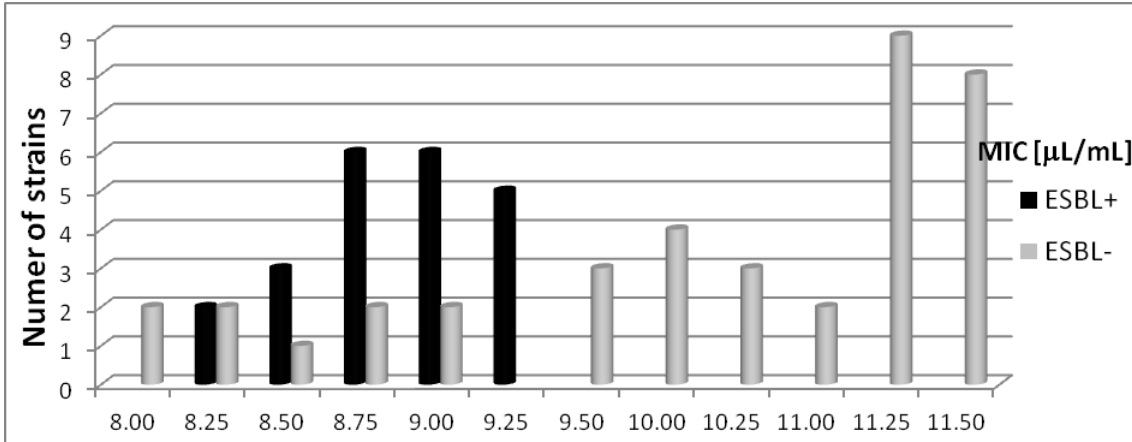
Figure 3. The susceptibility of Escherichia coli (ESBL+) and (ESBL − ) strains to basil